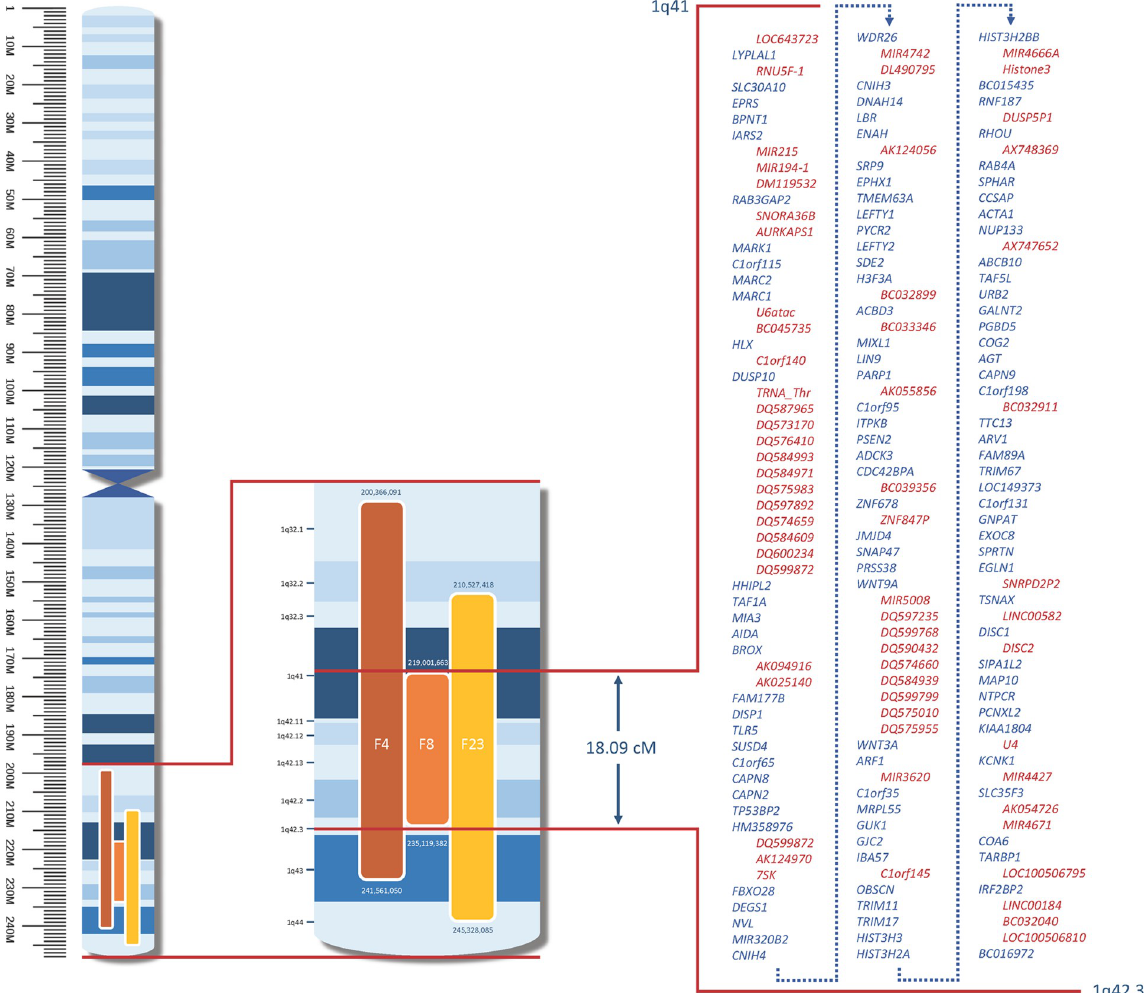
Fig 2. Candidate loci on chromosome 1. Coloured bars = loci supported by individual families; figures above and below these loci = physical (bp) position; bp = base pairs; M = mega base pairs; cM = centimorgan; red lines = enlarged overlap area; blue = protein-encoding genes; red = non-protein-encoding elements. All genes and positions in relation to GRCh37.p13